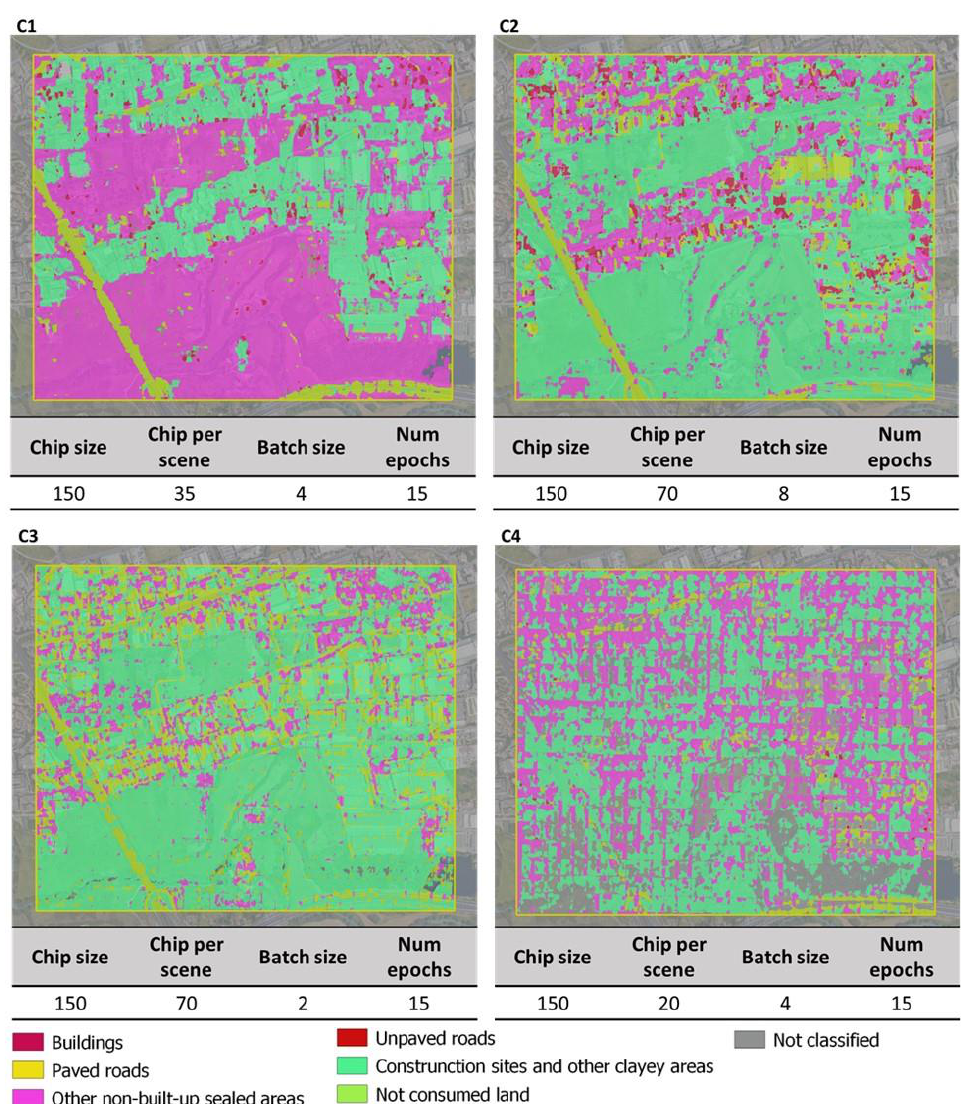
Figure 7. Classification examples relating to the third scenario, with reference to 4 distinct experiments. Table 2. Scores of the four best experiments related to the second scenario. Class 0 identifies non- consumed land; class 1 identifies consumed